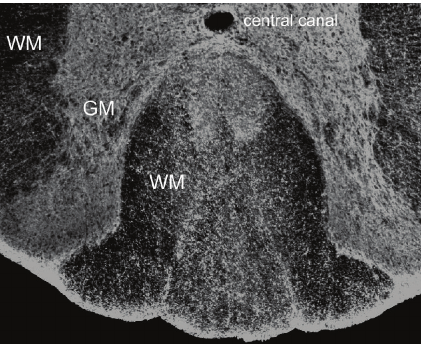
Figure 1: Distribution of HA (white) in lumbar spinal cord white matter (WM) and gray matter (GM). A section of a rat spinal cord was labeled with a biotinylated-HA-binding protein then visualized by fluorescence microscopy following staining with fluorescein- labeled streptavidin. Note that HA is diffusely distributed through- out white matter, but is much more dense in gray